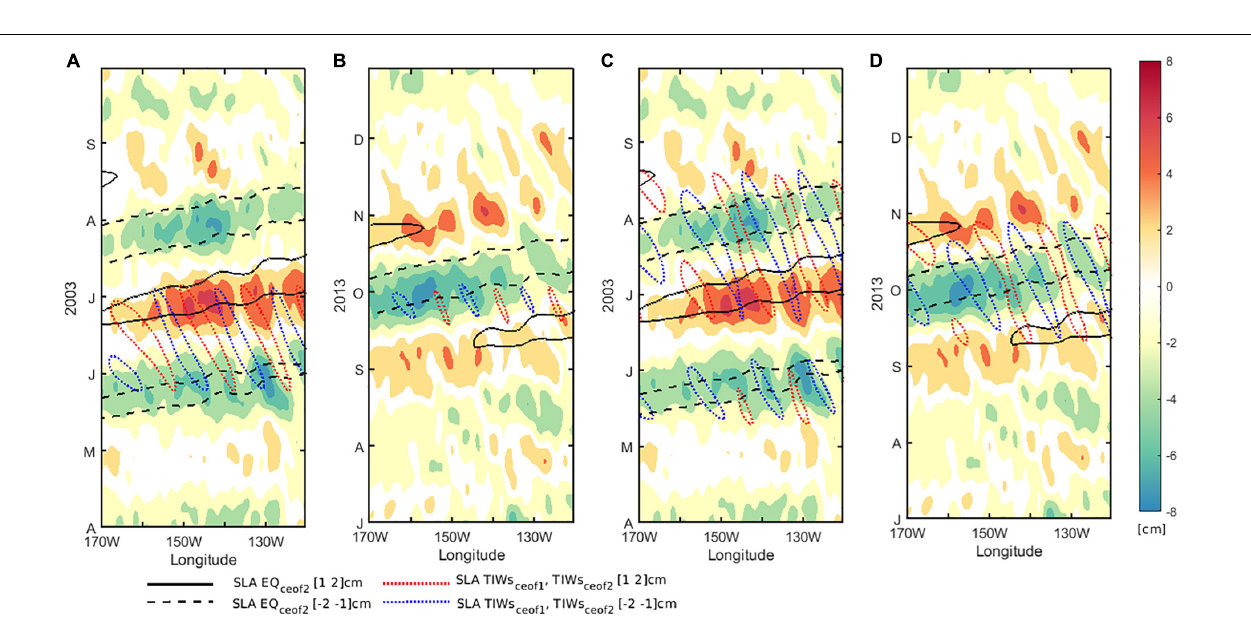
Frontiers in Marine Science |